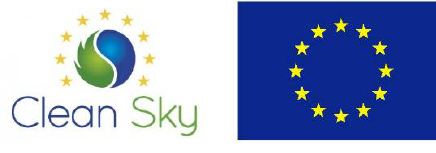
Figure 16. Mode shape orthogonalization verification with respect to the baseline configuration: ( a ) 0.5 kg on each side; ( b ) 1 kg on the forward corner; ( c ) 1 kg on the aft corner; ( d ) pushrod link failure; ( e ) pulling down aero pressure; and ( f ) pushing up aero